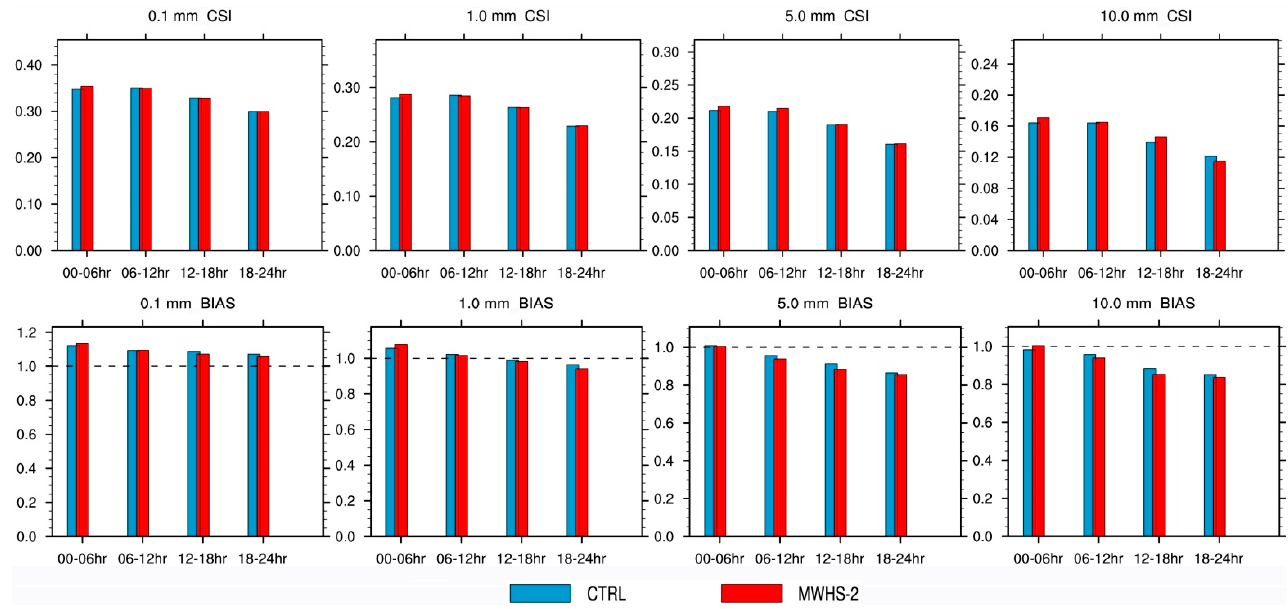
Figure 11. The CSI and BIAS scores of 6-h accumulated precipitation from the CTRL and the MWHS-2 forecasts in the nested 3-km domain for the threshold of 0.1 mm, 1.0 mm, 5.0 mm, and 10.0 mm.